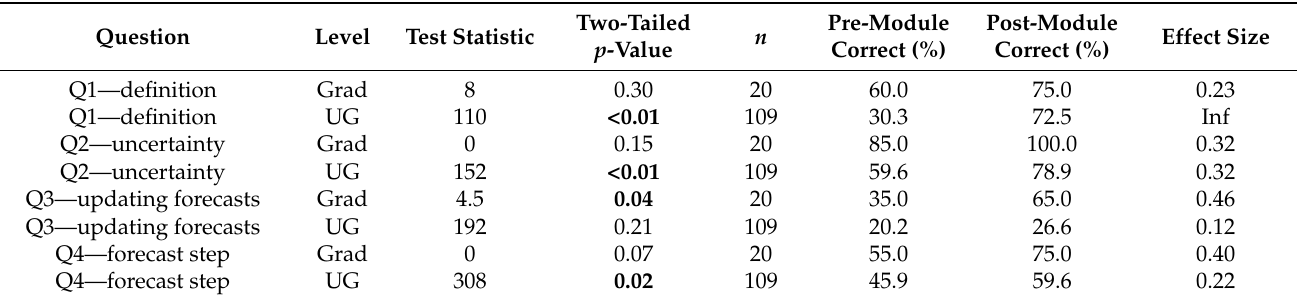
Table A7. Statistical differences in student pre- and post-module responses to the four multiple- choice, knowledge-based questions (Q1–4, described above and in text) for undergraduate (UG) and graduate (Grad) student levels. Test statistics and p -values are for paired, two-sided Wilcoxon signed-rank tests. Significant p -values ( p < 0.05) are shown in bold.